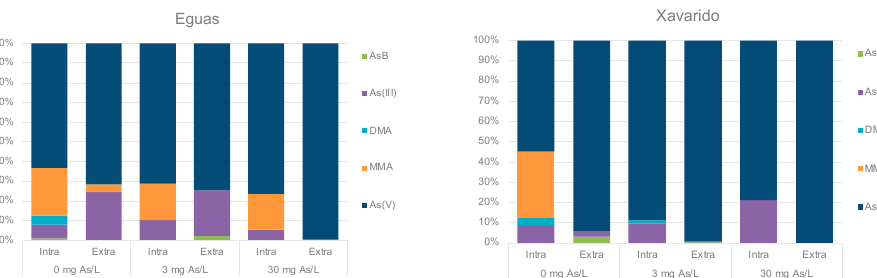
Figure 6. Distribution of extracellular and intracellular arsenic species found in 0, 3 and 30 mg L − 1 systems from Eguas (left) and Xavarido (right).